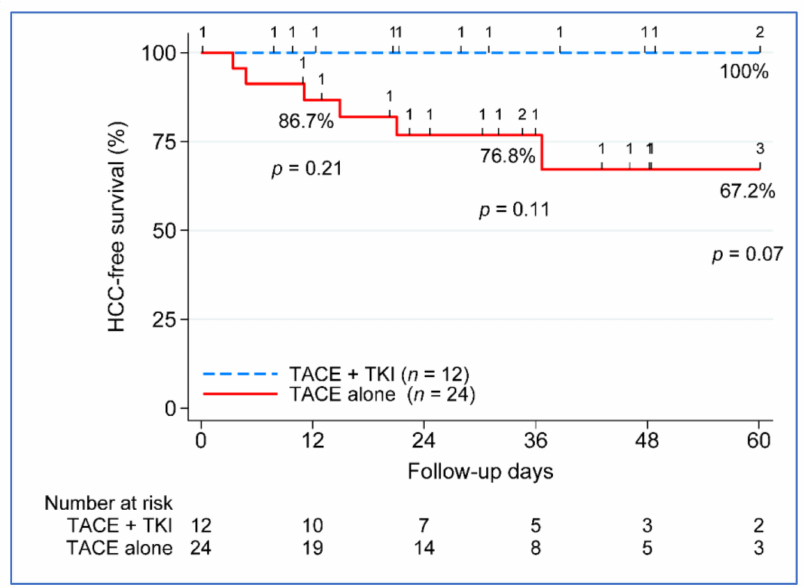
Figure 3. Five-year disease-free survival post-liver transplant. TACE, transarterial chemoemboliza- tion; TKI, tyrosine kinase inhibitor; and n , number.